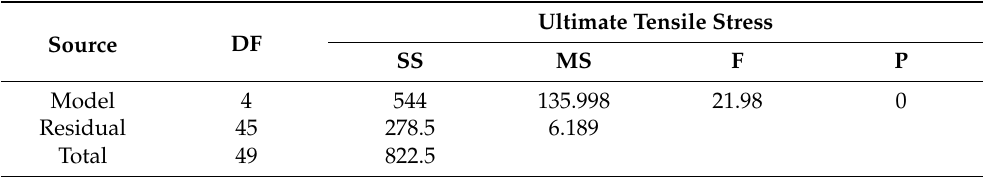
Table 5. Analysis of variance (ANOVA) of model for tensile stress. Degree of freedom (DF); sum of squares (SS); mean square (MS); F-ratio (F); p -value (P). Source